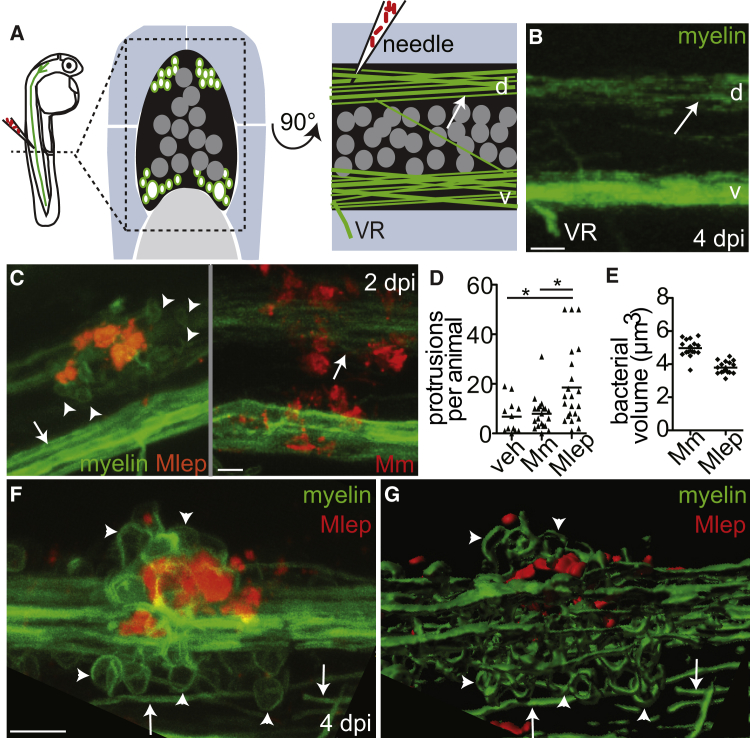
M. leprae Triggers Myelin Dissociation(A) Left, diagram of a spinal cord injection in an mbp:eGFP-CAAX larva (mbp), with fluorescent myelinating membrane, at 4 days post-fertilization (dpf). Transverse (middle) and sagittal (right) views of the region show the spinal cord (black), dorsal (d), and ventral (v) tracts of myelinated axons (green surrounding white axons), neuronal cell bodies (dark gray circles), and the ventral roots of spinal nerves (VR) surrounded by muscle (blue) and notochord (light gray). Arrows indicate intact myelin sheaths surrounding axons.(B) Confocal image corresponding to (A). Scale bar, 10 μm.(C) Representative confocal images of 4 dpf mbp larvae, 2 days post-infection (dpi) with ∼104M. leprae, or ∼200 CFUs of M. marinum; arrowheads indicate myelin protrusions, quantified in (D). Scale bar, 10 μm.(D) Mean number of myelin protrusions per animal following injection with PBS vehicle (veh), M. marinum, or M. leprae (∗p < 0.05; one-way ANOVA, Bonferroni’s post-test).(E) Mean bacterial burden of larvae from (C); measured by fluorescent pixel intensity like in Figure 1F.(F and G) Representative confocal image (F) and rendering (G) of myelin protrusions in a 6 dpf larva 4 dpi with ∼104M. leprae (Movie S1). Scale bar, 10 μm.See also Table S1 and Movie S1.